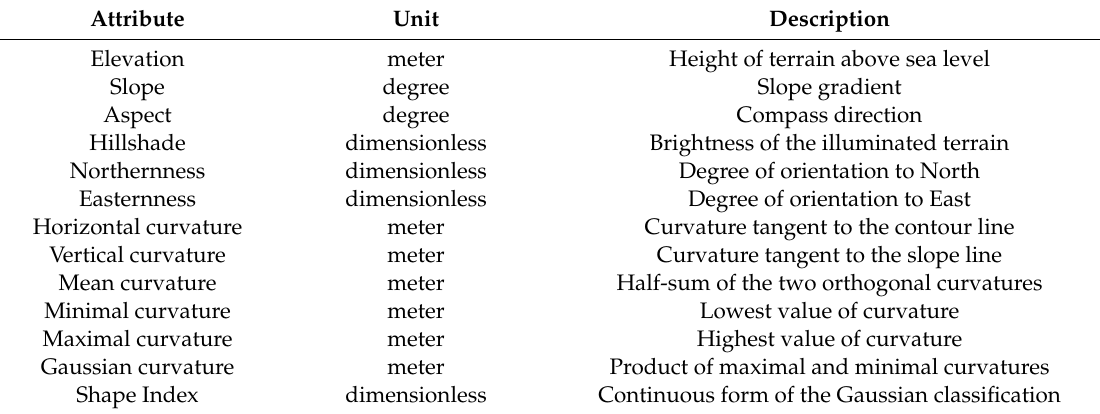
Table 1. Attributes of terrain, with their units and description, calculated by TAGEE